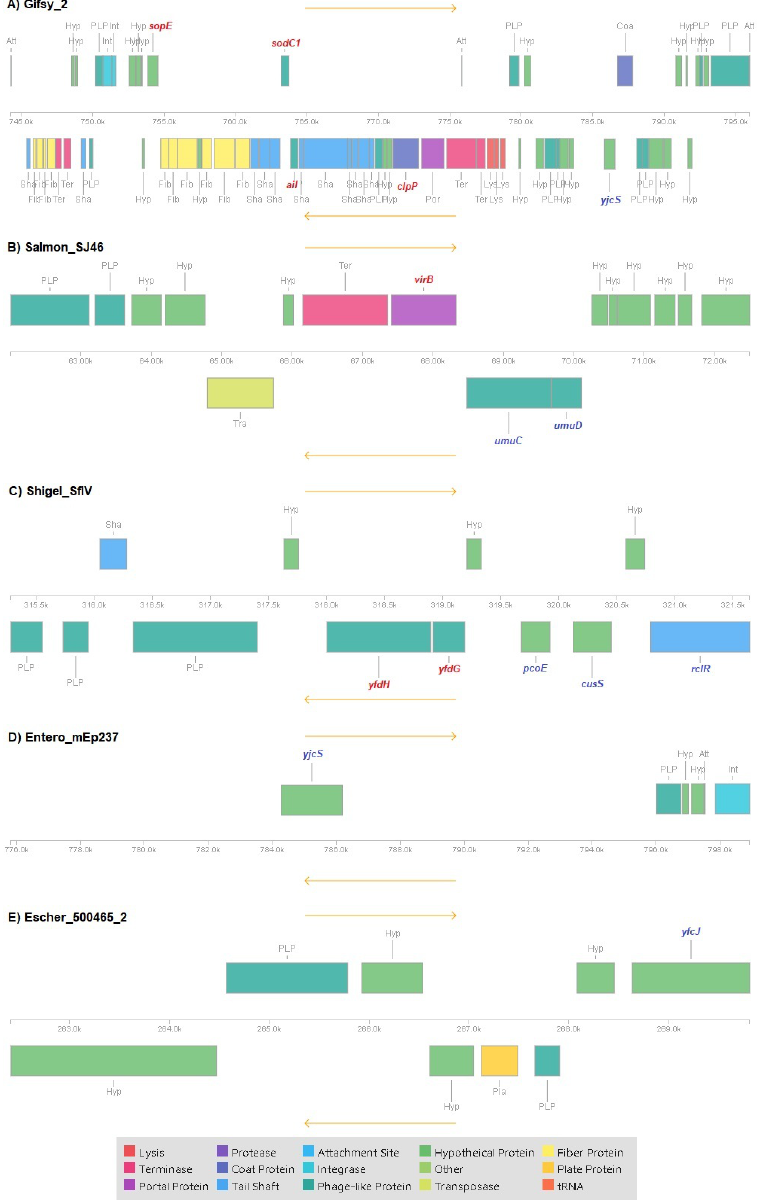
Figure 5. Genetic organization of the most common phages (MCPs) frequently detected in SG. lence and resistance genes are identified in red and blue, respectively. This figure was edited from a file generated using the Phaster tool